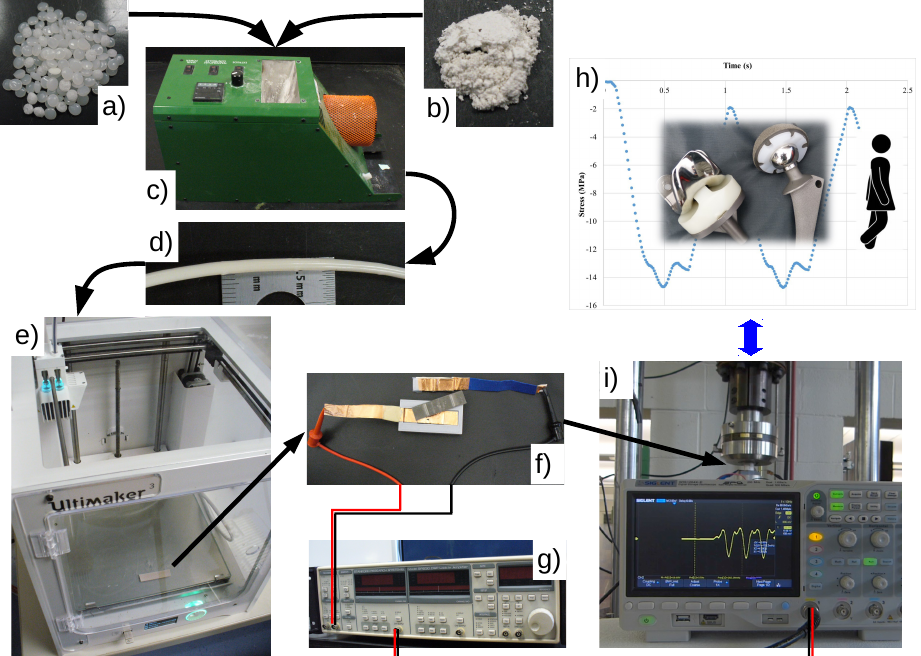
Figure 1. Materials, fabrication, and testing: ( a ) PVDF, ( b ) ZnO, ( c ) compounding and extrusion of the ZnO-PVDF nanocomposite into ( d ) 2.8 mm filaments were vacuum dried at 40 °C for 40 min, ( e ) 3D printing of test specimens, ( f ) electrically insulated test support with copper electrodes where the sample painted with conductive pain will rest, ( g ) lock-in amplifier connected directly to the test support electrodes, ( h ) walking profile with a 2 mm amplitude programmed into an MTS testing frame, and ( i ) measuring voltage generated during testing with an